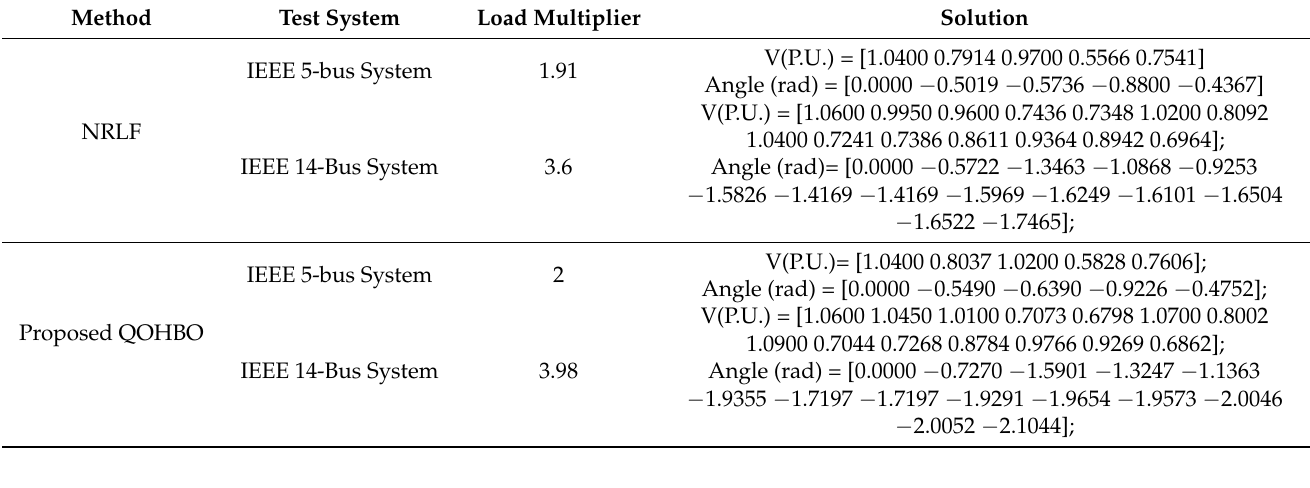
Table 3. Maximum load multiplier for loadability limit.